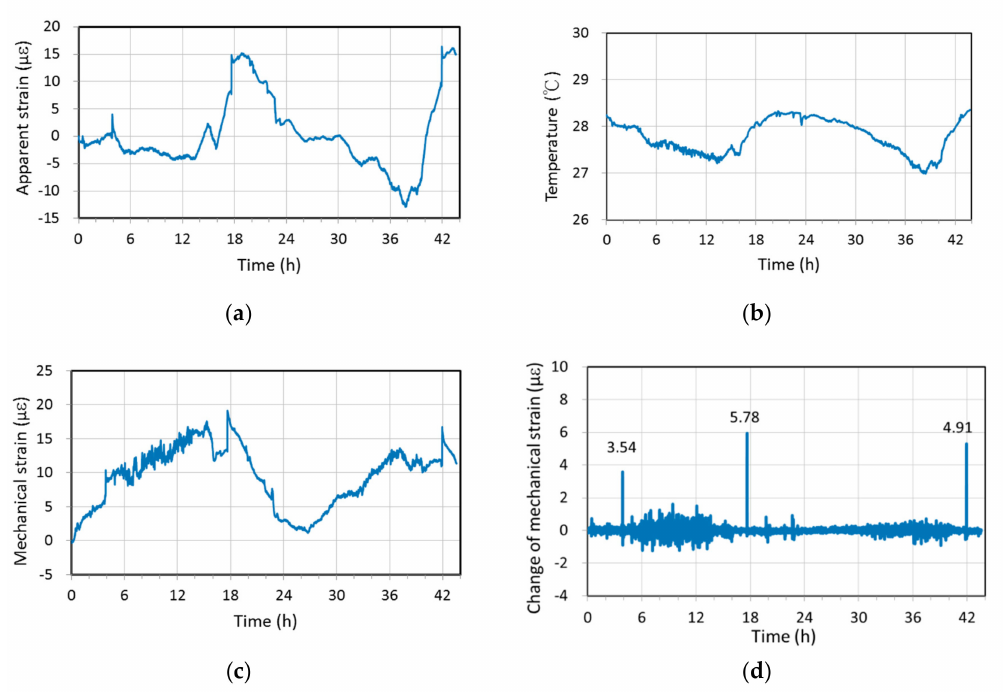
Figure 14. The concrete beam nonelastic response test: ( a ) strain response after deleting short-term loads; ( b ) beam bottom temperature changes; ( c ) mechanical strain; ( d ) change in mechanical strain per unit